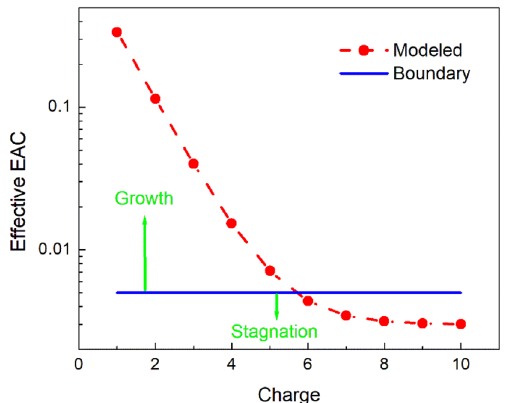
Figure 4. The effective EAC vs. the positive nanoparticle charge. The dashed line is a guide to the eye. The horizontal line is the boundary between areas of “condensation growth” and “condensation